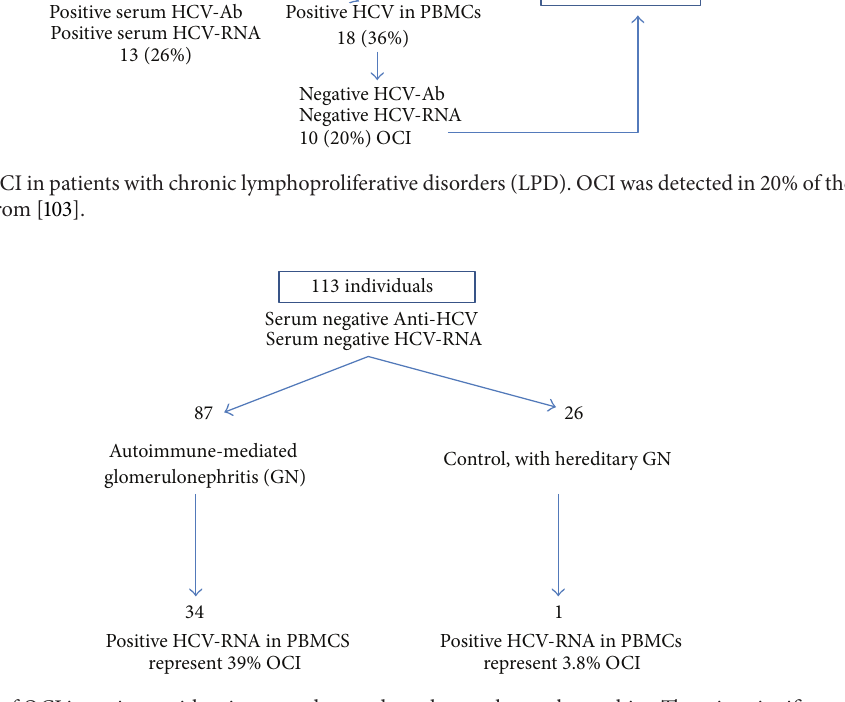
Figure 2: The prevalence of OCI in patients with primary and secondary glomerular nephropathies. There is a significant increased risk (odd ratio 13.29) of OCI in patients with immune mediated glomerulonephritis versus the controls